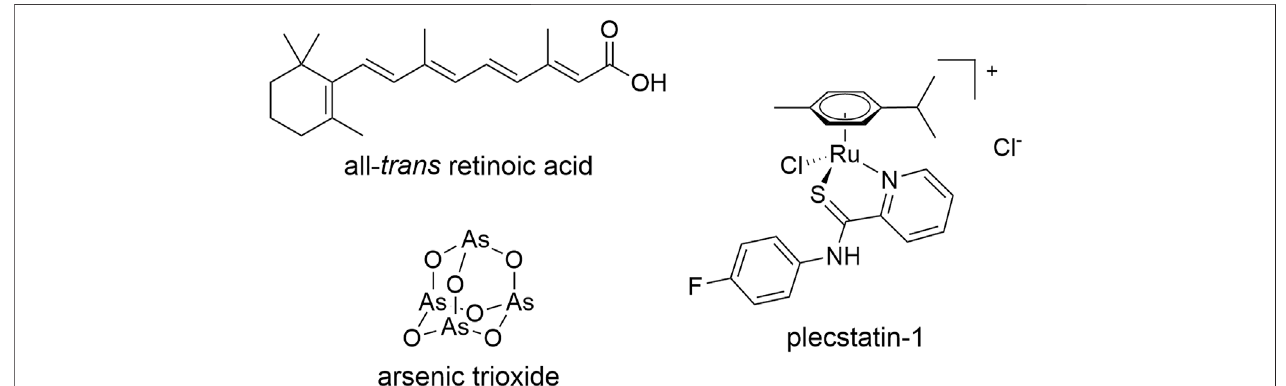
FIGURE 1 | Chemical structures of the compounds used in this